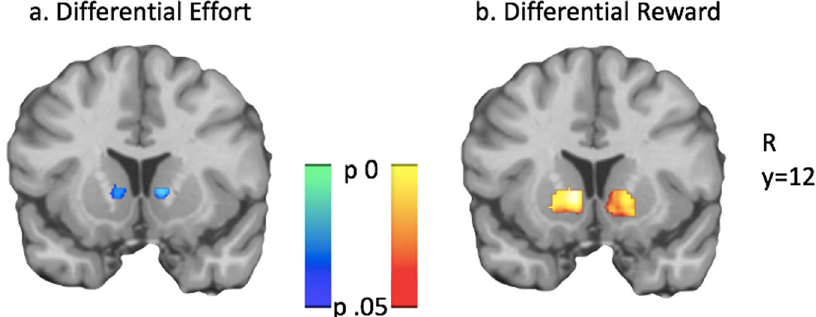
Fig. 3 Effort and reward exert opposite effects in VS. Differential effort (HARD – EASY) suppressed VS activation ( a ), while differential reward positively activated VS ( b ). Signi fi cance is determined within VS